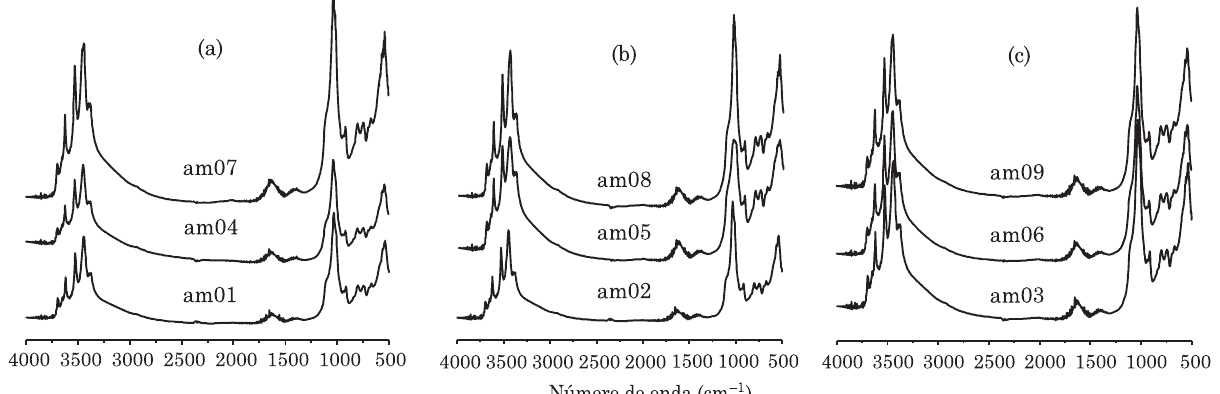
Figura 1. Espectros obtidos por IV para as nove amostras analisadas nos diferentes manejos e profundidades. Profundidades: (a) 0,0 – 0,20 m, (b) 0,20 – 0,40 m e (c) 0,40 – 0,60 m; em cada um dos gráficos, os espectros do inferior ao superior representam os manejos: PC, PM e PD,